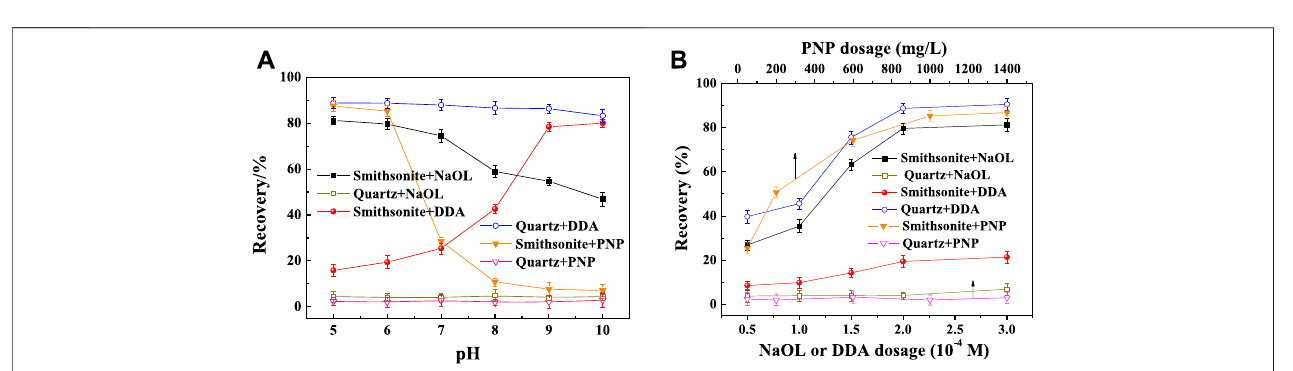
Frontiers in Chemistry |